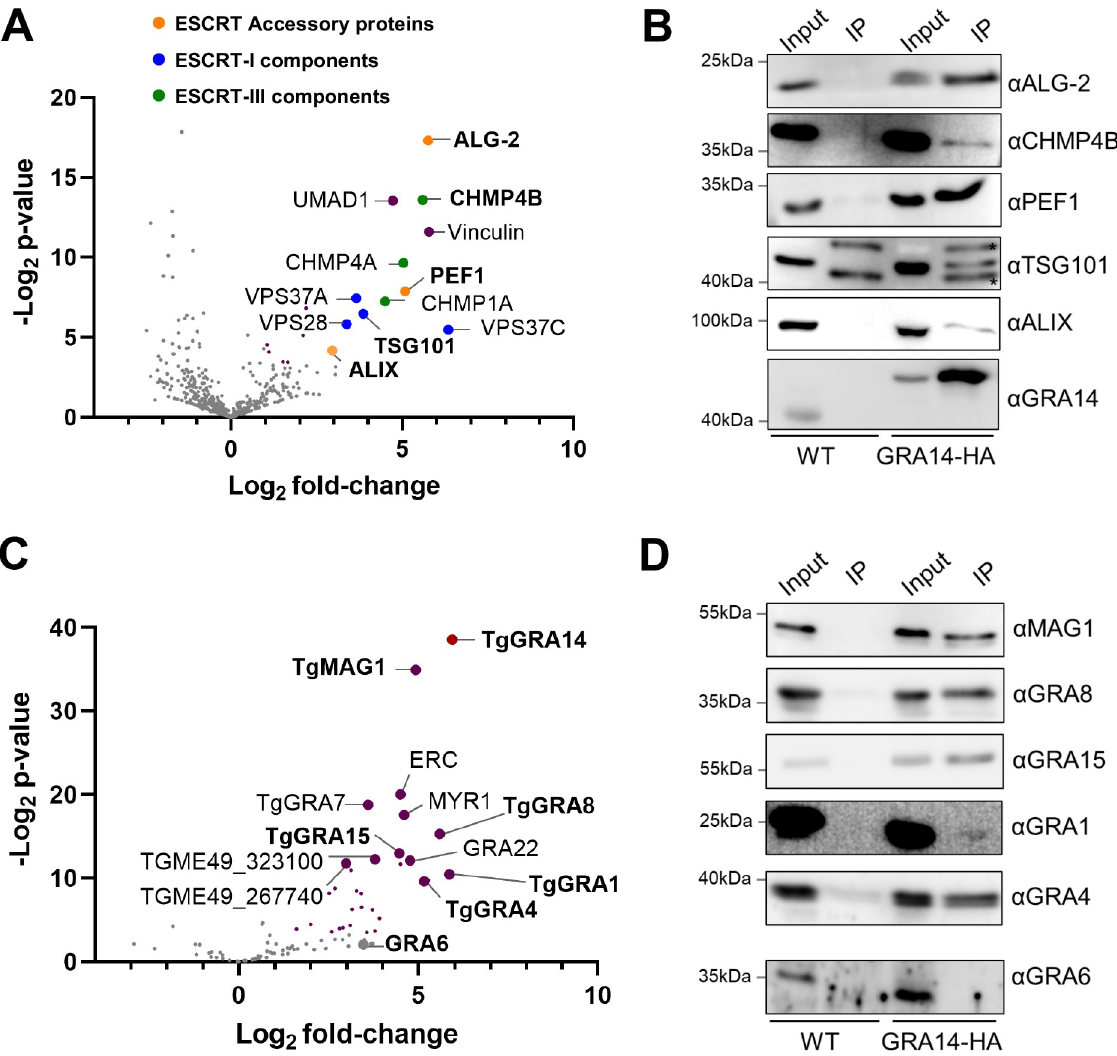
Fig 5. Host ESCRT components immunoprecipitated with TgGRA14. A. Volcano plot of the host proteins immunoprecipitated with TgGRA14 under tachyzoite infection conditions showing the ESCRT-accessory proteins (orange), ESCRT-I components (blue), ESCRT-III components (green) and other non-ESCRT associated proteins (purple). Colored dots represent proteins with > 1 log2 fold change in tagged vs control lysates and a negative log2 p-value > 3.32 (equivalent to p < 0.1). B. Immunoblots for the analysis of immunoprecipitation samples confirming the TgGRA14 interaction with host ESCRT components. C. Volcano plot representative of the T . gondii proteins immunoprecipitated with TgGRA14. Some of the enriched dense granule proteins are highlighted in purple. Colored dots represent proteins with > 1 log2 fold change in tagged vs control lysates and a negative log2 p-value > 3.32 (equivalent to p < 0.1). D. Immunoblot analysis of immunoprecipitation samples confirming the TgGRA14 interaction with some of the enriched dense granule proteins.